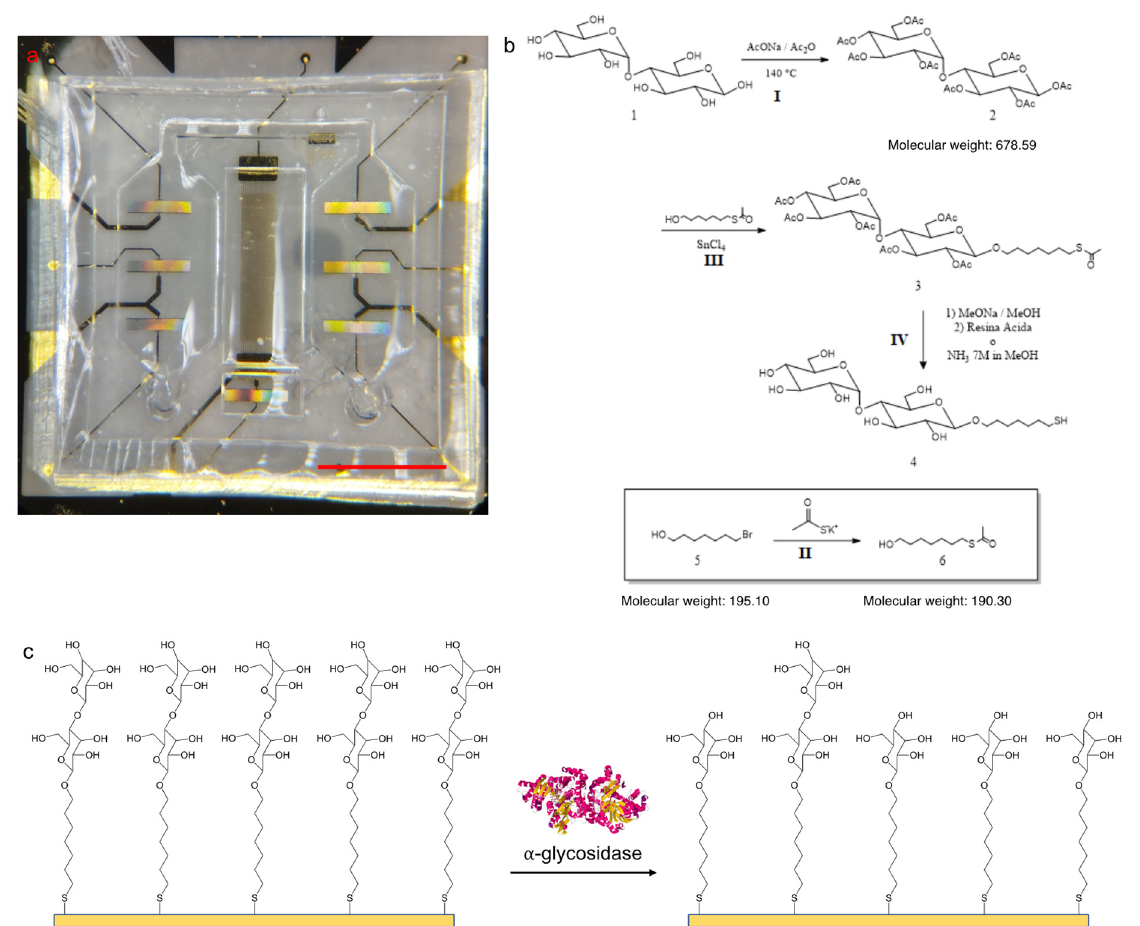
Figure 1. The proposed SAW-LoC biosensor: ( a ) assembled device, in which the sensors are covered with the microfluidic chamber, scale bar = 0.3 cm; ( b ) reaction scheme of the probe synthesis; ( c ) illustration of the sensor working principle: the maltoside moieties, indicated with a double blue circle, are enzymatically converted releasing glucose units.